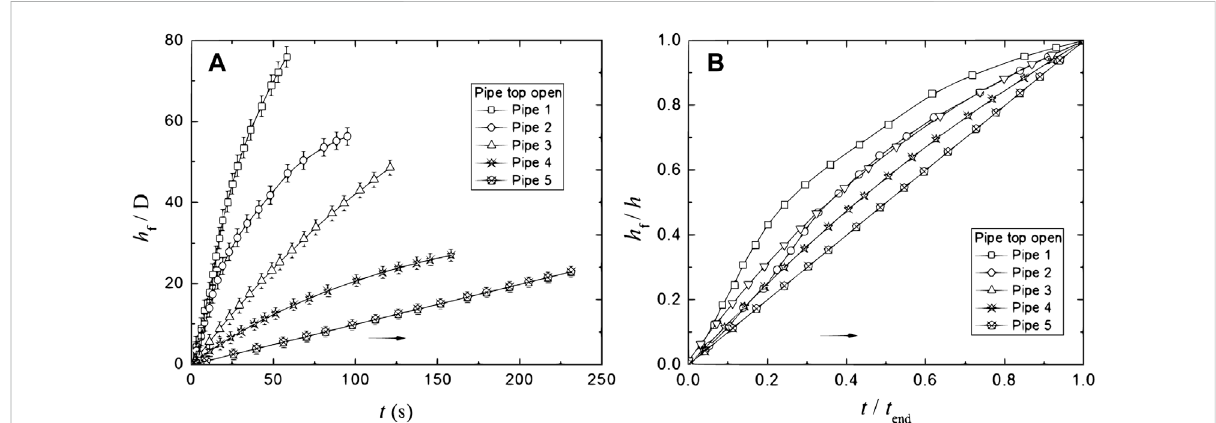
FIGURE 2 (A) Measuredheightofthefoamfrontnormalizedtothepipediameter, h f / D ,asafunctionoftimeforvarying D aslistedinTable1forthecaseof opentoppipes.Theerrorbarsdepicted oneachmeasurement corresponds to thestandarderrorcalculatedas thestandarddeviation dividedbythe square root of the number of measurements. The standard errors are: 5.0% for Pipe 1, 4.7% for Pipe 2, 4.3% for Pipe 3, 4.1% for Pipe 2, and 3.8% for Pipe 5 with con fi dence intervals around 95%. (B) Same data as in (A) but normalized to the height of the vertical pipe, h f / h , as a function of time normalized to the foam generation time, t / t end . The arrows in (A) and (B) indicate the direction in which the pipe diameter increases.